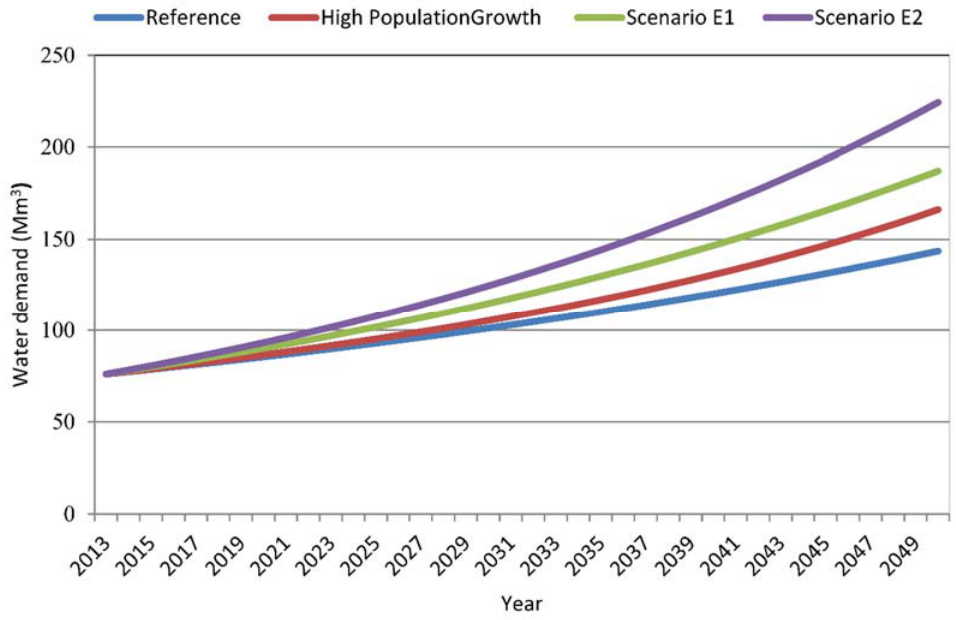
Figure 7. Annual water demand in million cubic meters for the scenarios reference (business as usual), high population growth and socio-economic development from 2013–2050 assuming a constant climate.